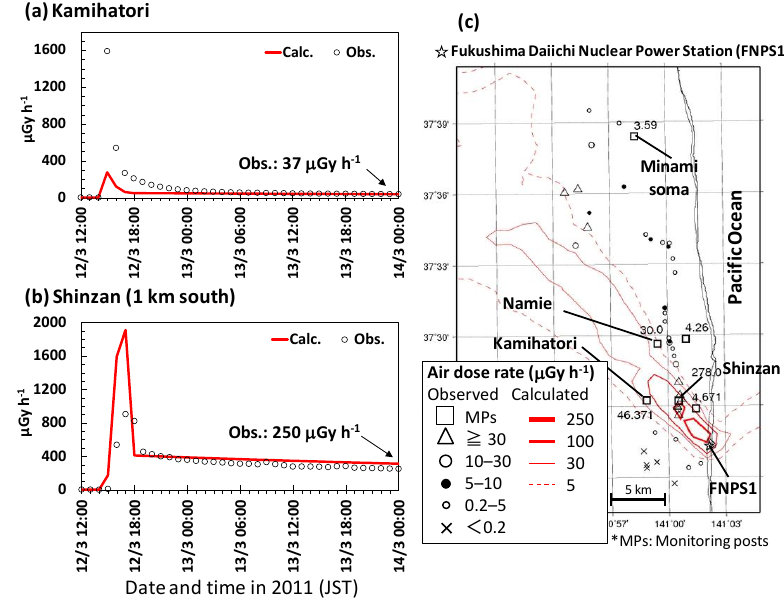
Figure 6. Time series of calculated (solid lines) and observed air dose rates (open circles) at the automated monitoring posts (a) Kamihatori and (b) Shinzan (1km south of the actual monitoring post of Shinzan), and (c) comparison of the calculated air dose rates at 12:00 on 13 March 2011 in the north-northwest area of the FNPS1 versus measurements from 06:00 to 15:00. In (b) , the calculated air dose rate at 1km south of Shinzan was compared with the observed one because the principal axis of the calculated plume seemed to be several kilometers further west from that of the observed